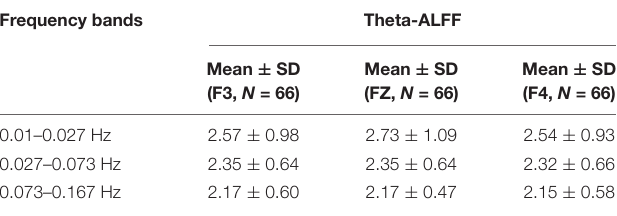
TABLE 4 | Theta-ALFF in each frequency